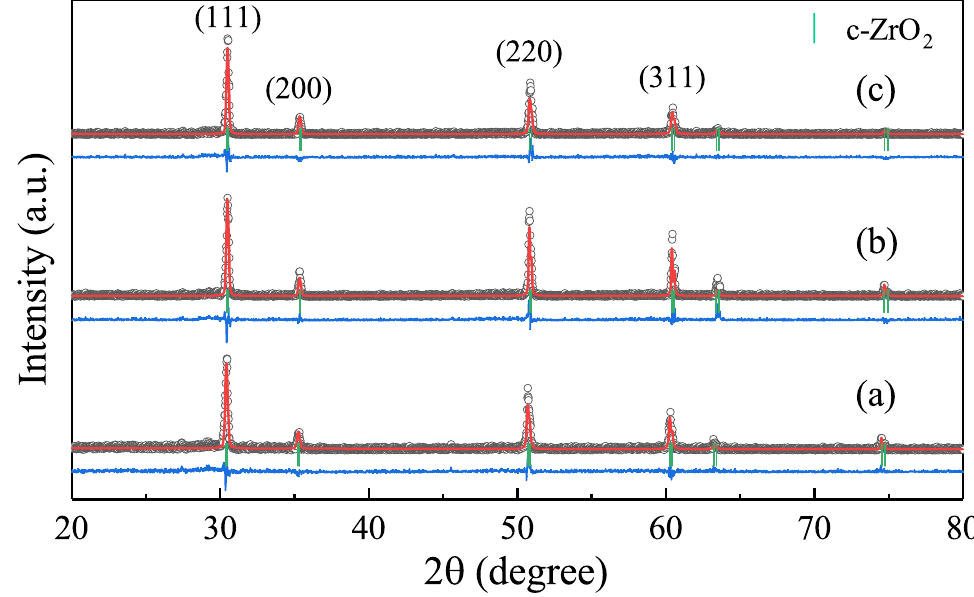
Figure 1. X-ray diffraction patterns along with their Rietveld refinement patterns of